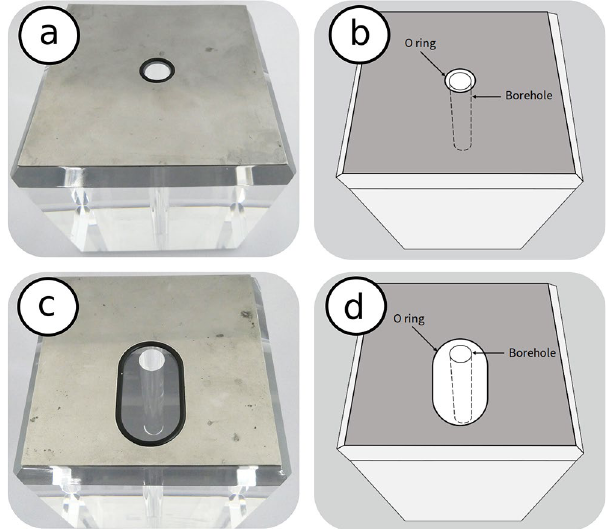
Figure 11. Chamfered cubic samples of PMMA with a circular ( a , b ) or an elliptical ( c , d ) opening of the stainless steel gasket. The elliptical configuration is employed to generate a non-uniform and non-symmetric stress distribution in the